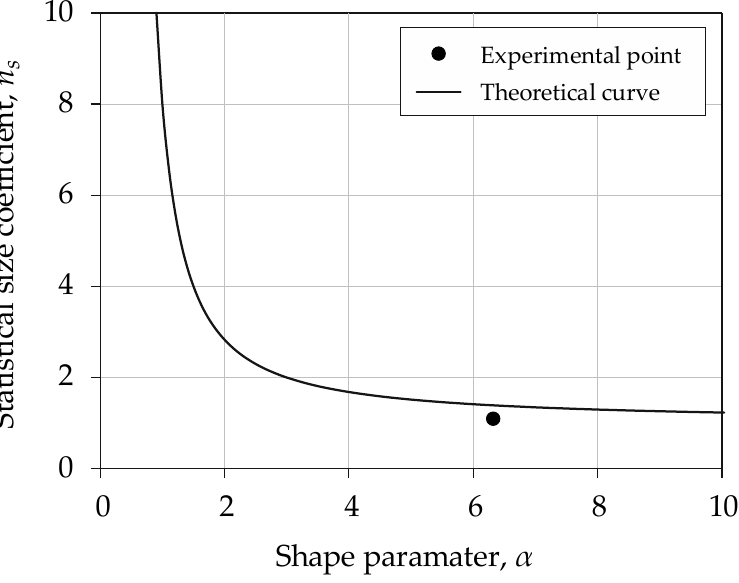
Figure 9. Coefficient n s to shape parameter α for 1.4301 steel. Figure 9. Coe ffi cient n s to shape parameter α for 1.4301